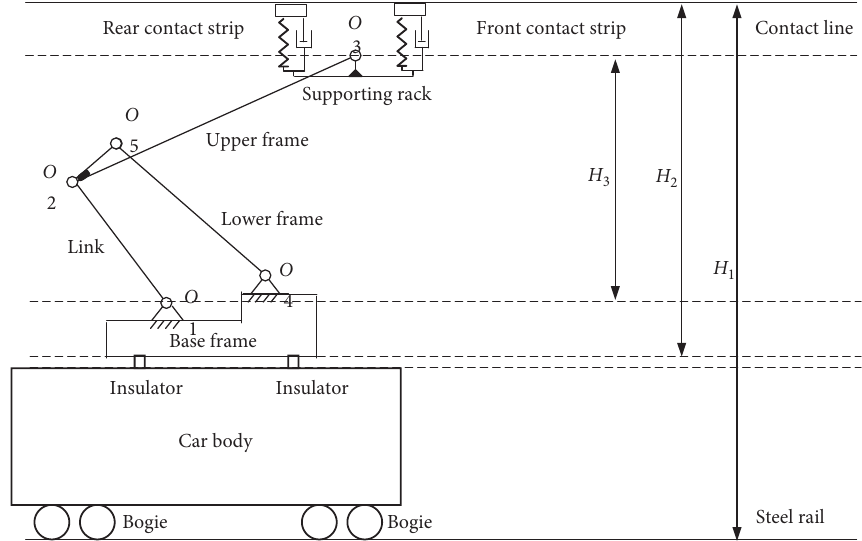
Figure 13: Important height values relating to the pantograph-catenary